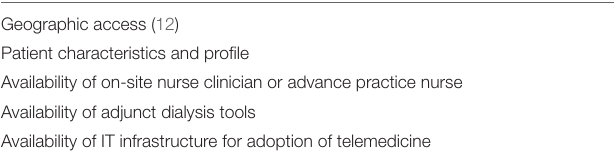
TABLE 1 | Factor determining the frequency of physical review. Geographic access